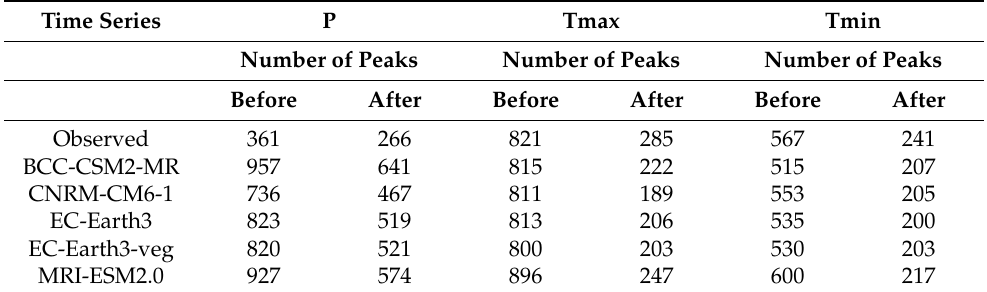
Table 3. The number of peaks for the daily P, Tmax, and Tmin extremes from observed and GCM simulated data before and after declustering for the period of